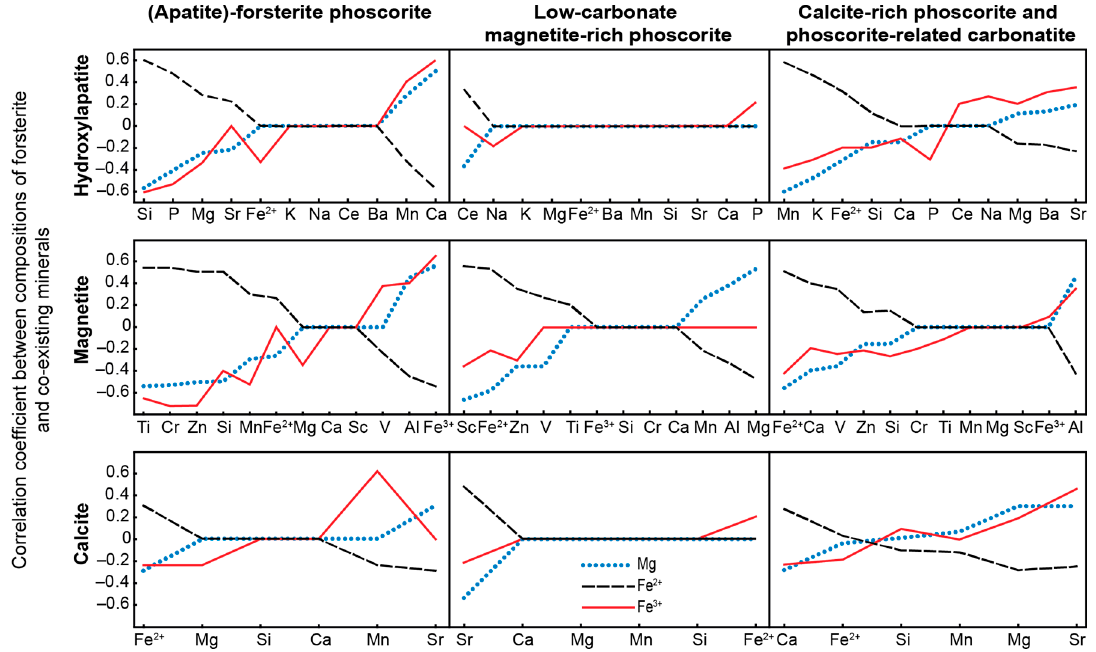
Figure 9. Correlation coefficients of forsterite composition with hydroxylapatite, magnetite and calcite compositions.